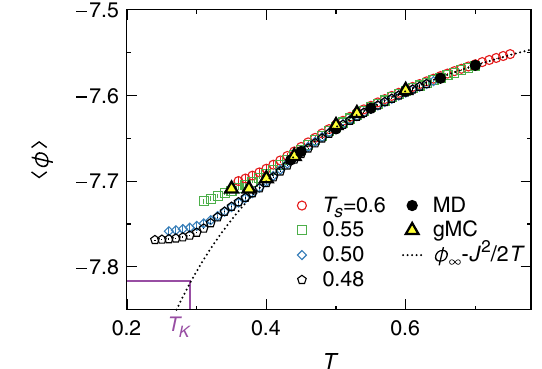
FIG. 2. Importance sampling of inherent state energies at 0 . 60 , 0.55, 0.50, 0.48. The dotted sampling temperatures T s ¼ line indicates the prediction of Eq. (10) for the equilibrium liquid, filled circles represent the values obtained from unbiased molecular dynamics simulations, and yellow triangles indicate the equilibrium values obtained via a ghost-particle Monte Carlo (gMC) technique (see text and Appendix A). Deviations from the equilibrium liquid occur only at low T and become smaller if the sampling is performed at lower T . Also indicated is the s putative value of the Kauzmann temperature T and the corre- K sponding energy of the equilibrium liquid. Notice that trajectory 0 . 50 , 0.48 outperforms the longest Monte Carlo sampling at T s ¼ calculations at the lowest temperatures, reaching much deeper inherent state energies. In particular, the lowest temperature estimate of the inherent state energy in the gMC shows that the Monte Carlo technique can also remain trapped in long-lived metastable states similar to the ones obtained via trajectory sampling at high T . s